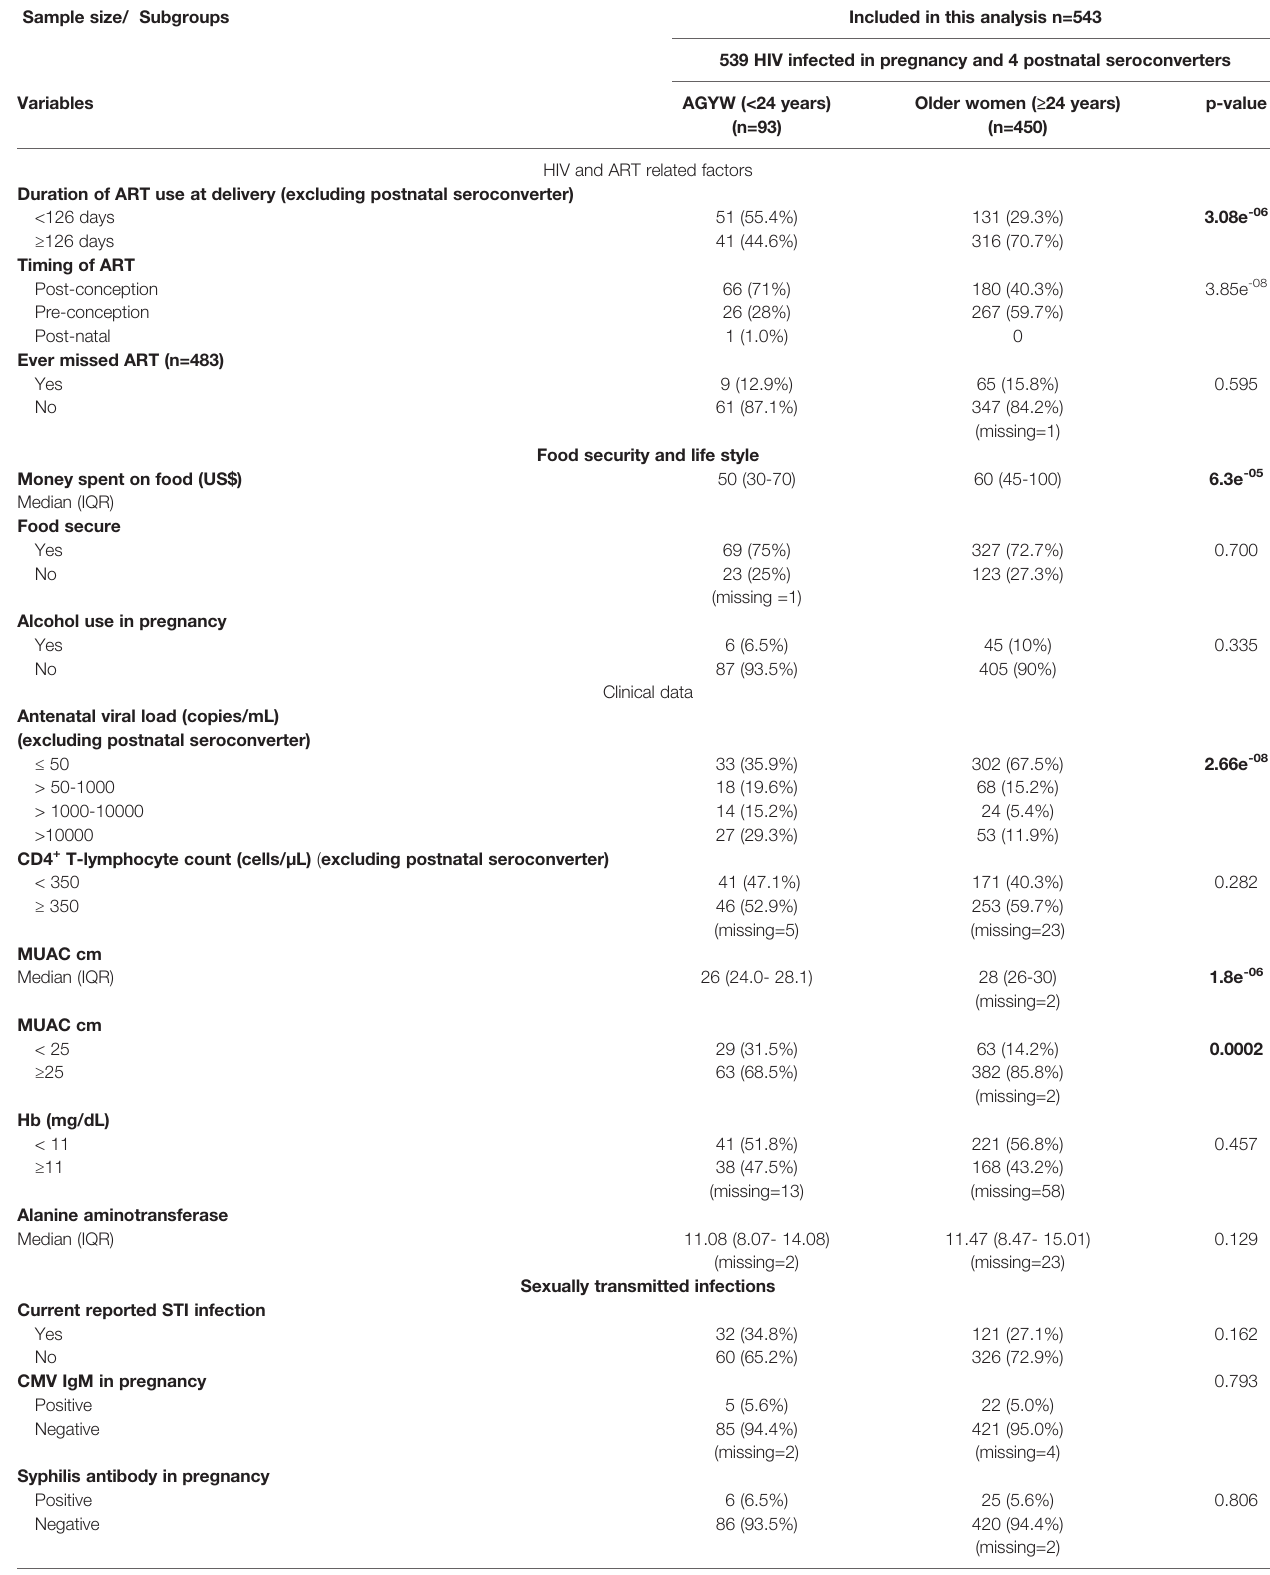
TABLE 2 | Demographic and clinical characteristics, HIV- and ART-related factors, clinical data, presence of sexually transmitted infections, and birth outcome/infant factors of HIV-infected adolescent girls and young women (15 – 24 years old) versus HIV-infected older women >24